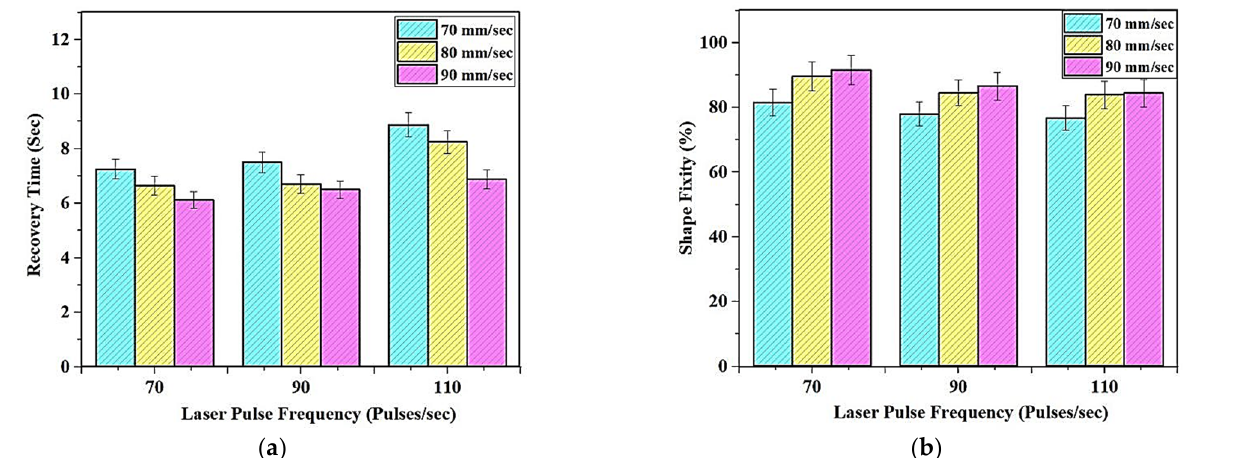
Figure 8. Variation of ( a ) Recovery time ( b ) Shape fixity with the corresponding change in print parameters.